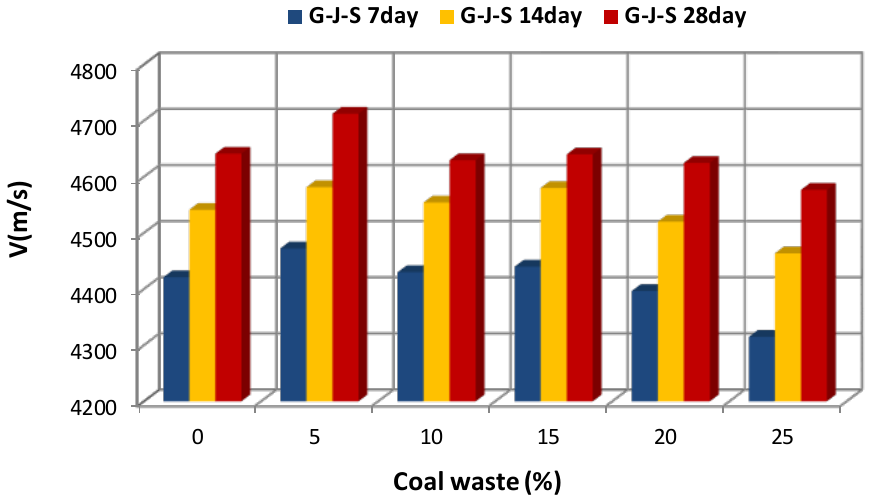
Figure 11. The effect of concrete age on the UPV of the G-J-S group .